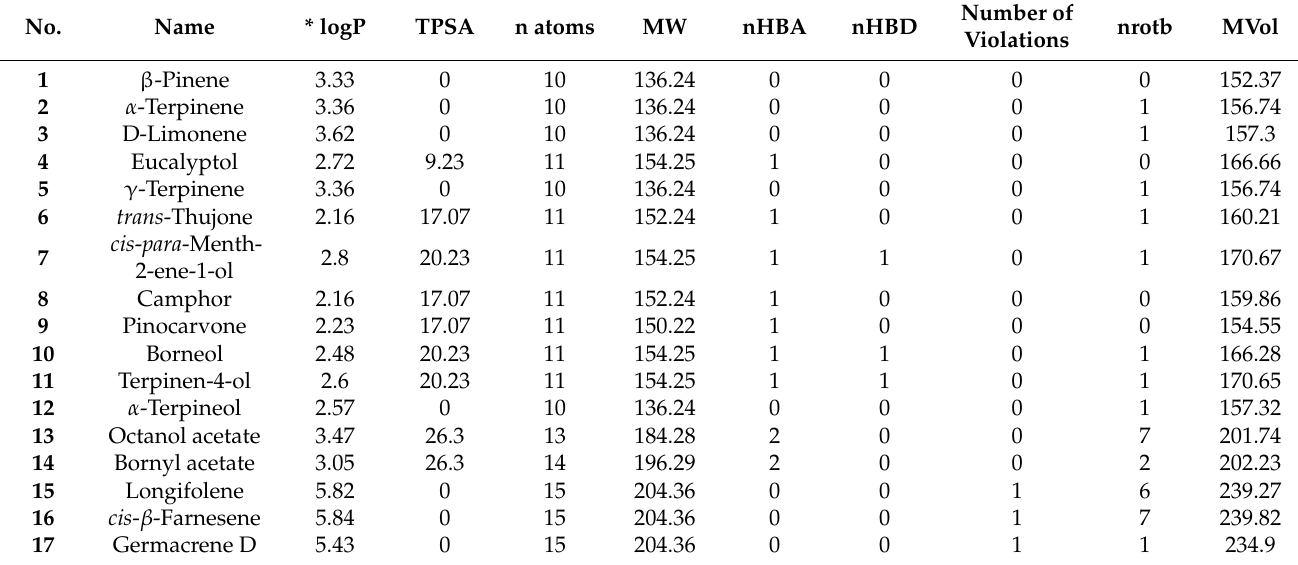
Table 3. Drug-like properties of both C. anthemoides essential oil